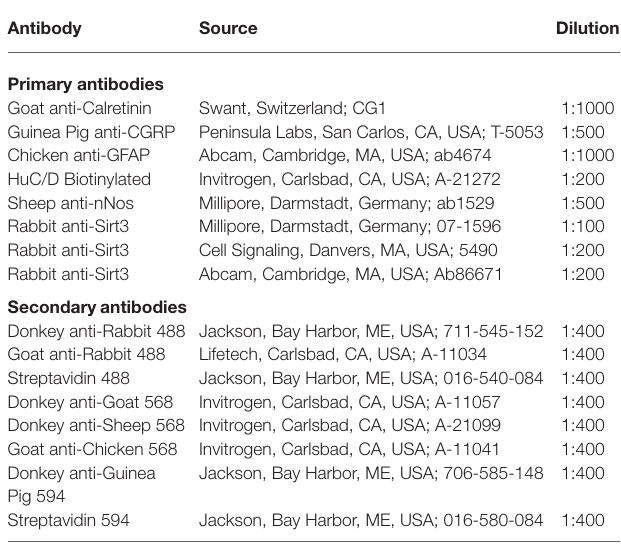
TABLE 1 | Antibodies used in this study